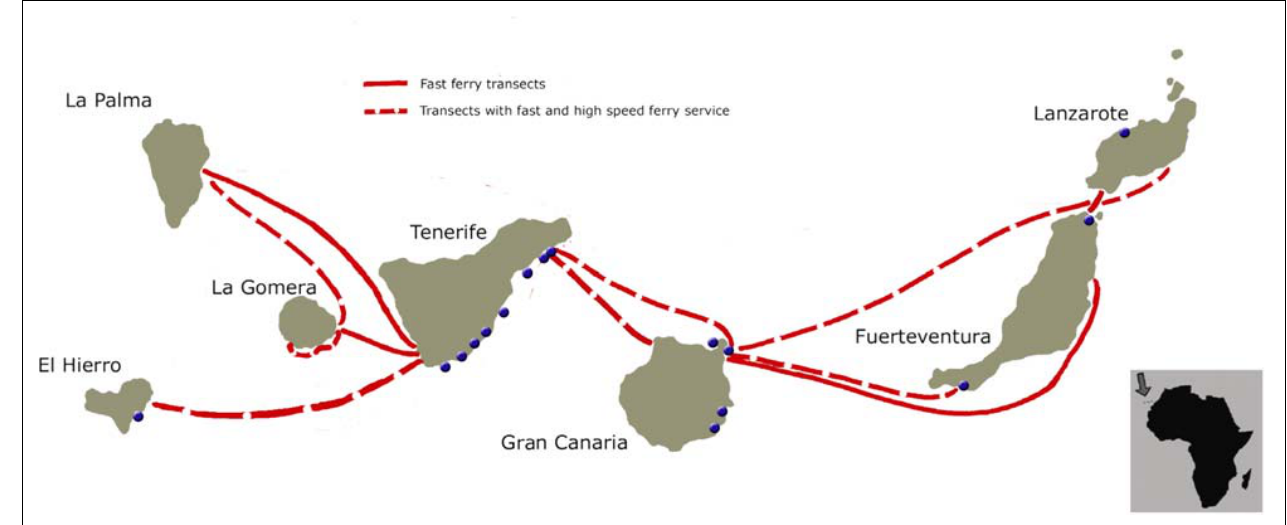
FIGURE 5 | Inter-island ferry transects in the Canary Islands (different speed-ferries are represented with different line types), and stranding locations (blue dots) of the sperm whales with evidence of ship strikes in the Canary Islands [modified from Ritter